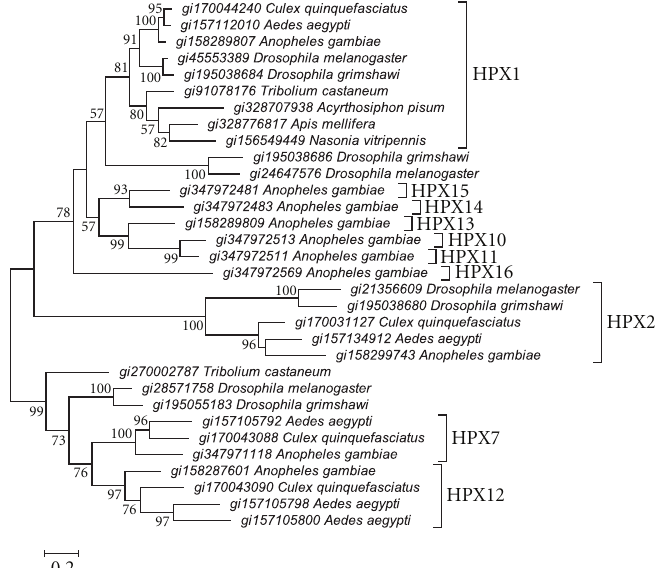
Figure 2: Maximum likelihood tree of select insect heme peroxidases, based on the WAG+G+I model at 402 aligned amino acid sites. Numbers on the branches represent the percentage of 1000 bootstrap pseudosamples supporting the branch; only values ≥ 50% are